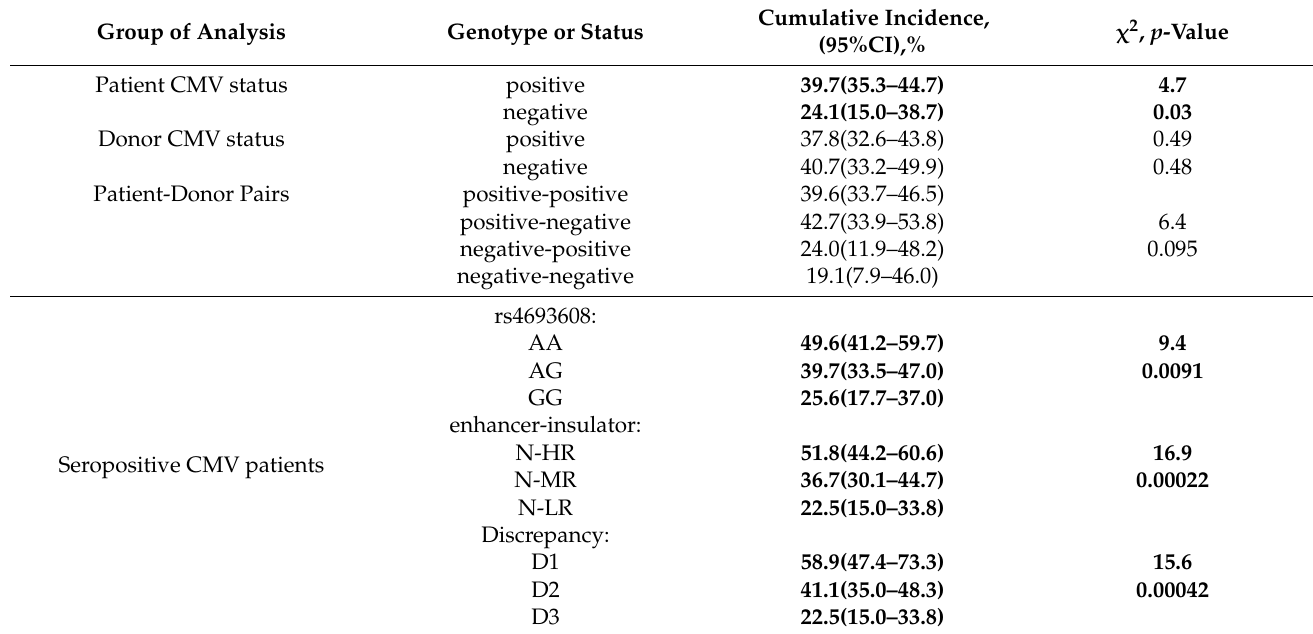
Table 5. Univariate analysis of cumulative incidence of acute GVHD in association with patient enhancer and insulator HPSE gene SNPs and CMV